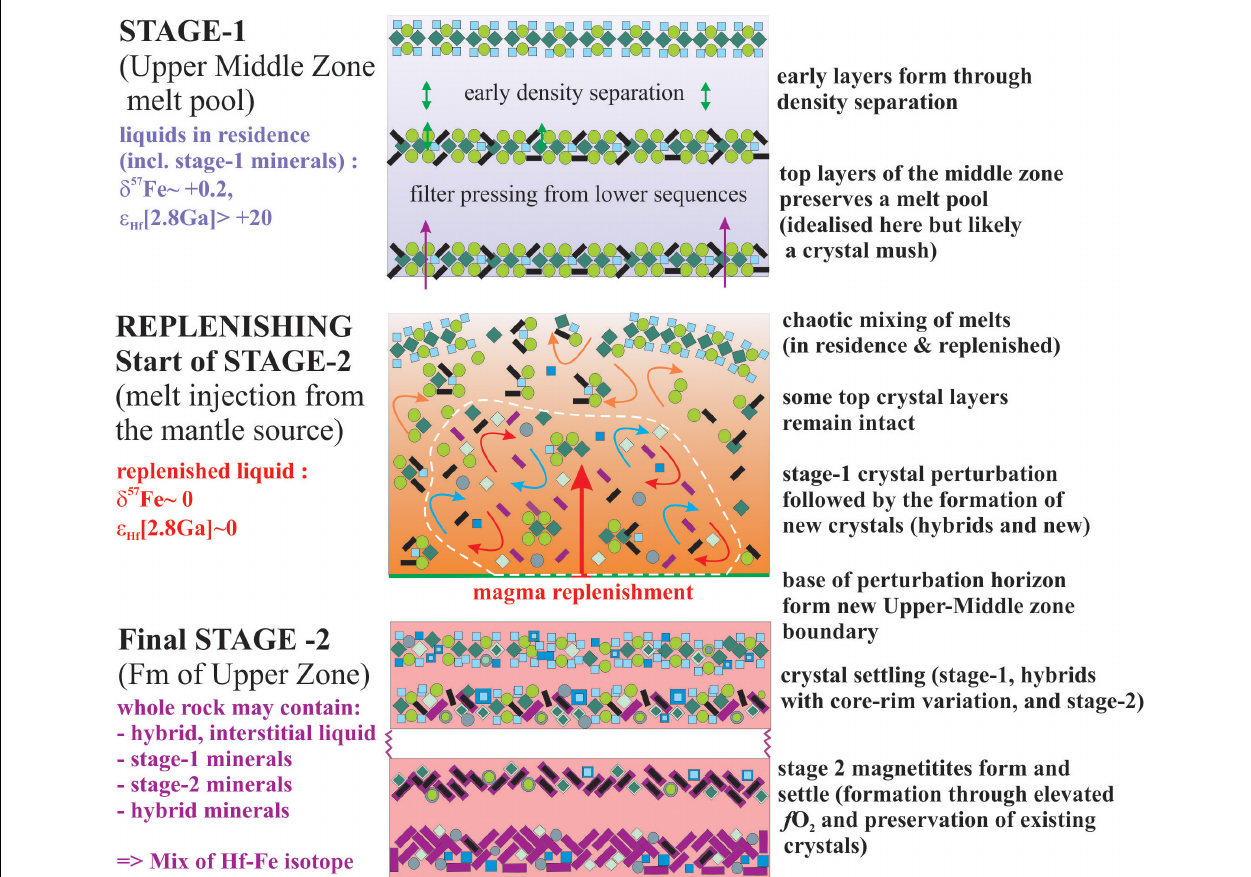
FIGURE 5 | Schematic sketch of the temporal two-stage evolution of the Upper Zone magma-reservoir. Prior to melt replenishment, a melt pool, possibly with initial layering, was established in the roof zone of the (now) Middle Zone of the intrusion, which formed the top part of the intrusion. Residual liquids accumulated through filter pressing with a heavy Fe isotope composition of δ 57 Fe ∼ + 0.2